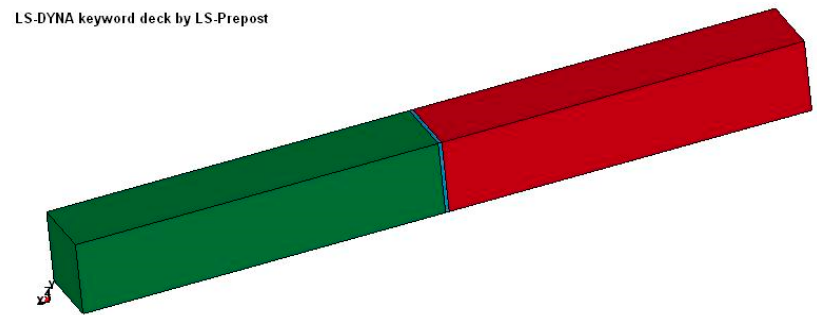
( b ) Figure 10. Training process performance curve ( a ) and the BP neural network prediction of momentum transfer ( b ). 5. Finite Element Analysis The commercial code LSDYNA was used to calculate the problems of Taylor’s model, as well as the generalized model. In LSDYNA, solid elements were used to model the bar in the configuration shown in Figure 11. On the cross section of the fluid bar, the solid elements were 0.2 m × 0.2 m squares,